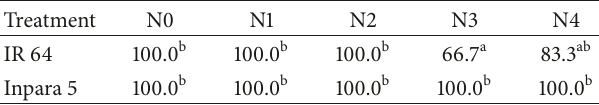
Table 2: Percentage of survive plant (%) of two rice varieties and fertilizing treatment in condition of dirty water submergence